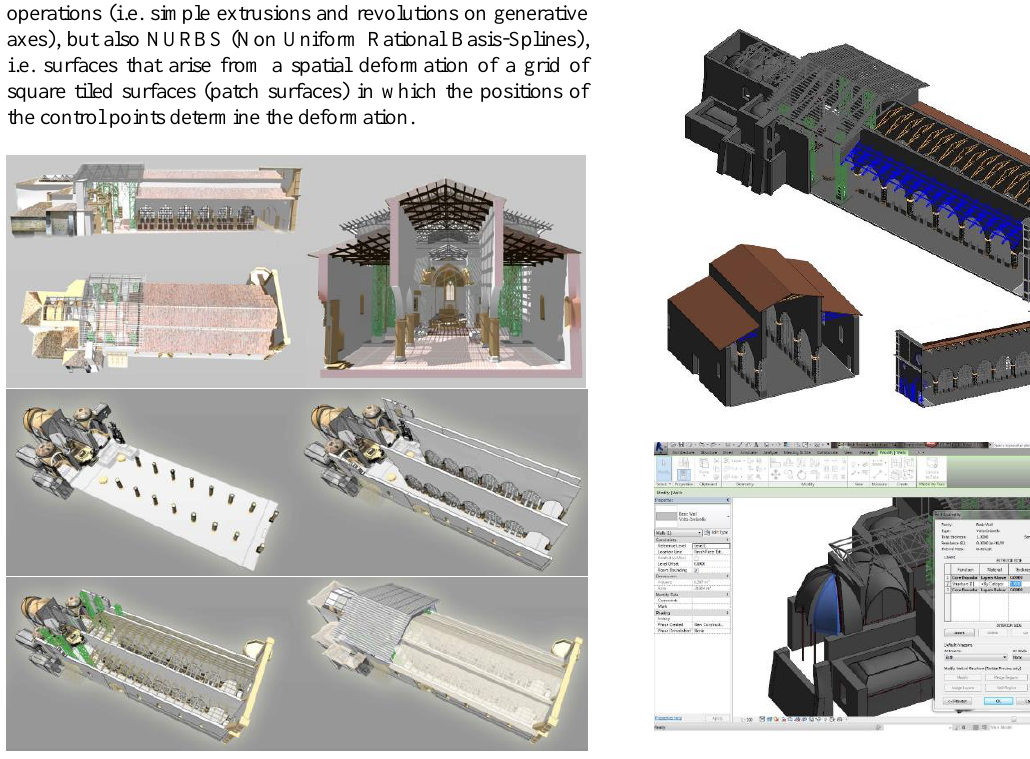
Figure 6. 3D views of the model obtain in ©Rhino from laser point clouds acquired with a Faro Focus 3D.